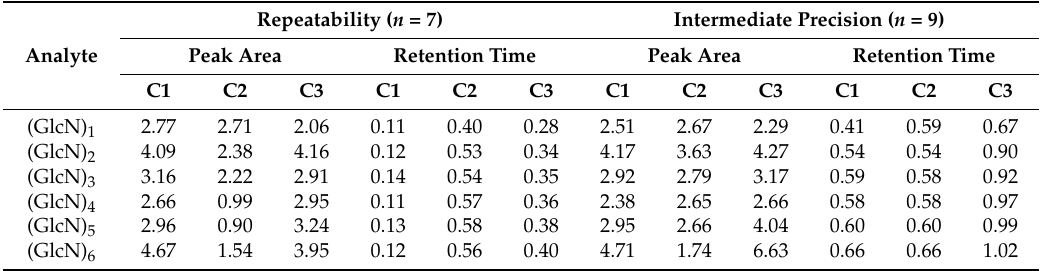
Table 2. Determination of method precision under repeatability (intraday) and intermediate precision (interday) conditions given as RSD (%) of peak area and retention time. Repeatability ( n = 7) Analyte